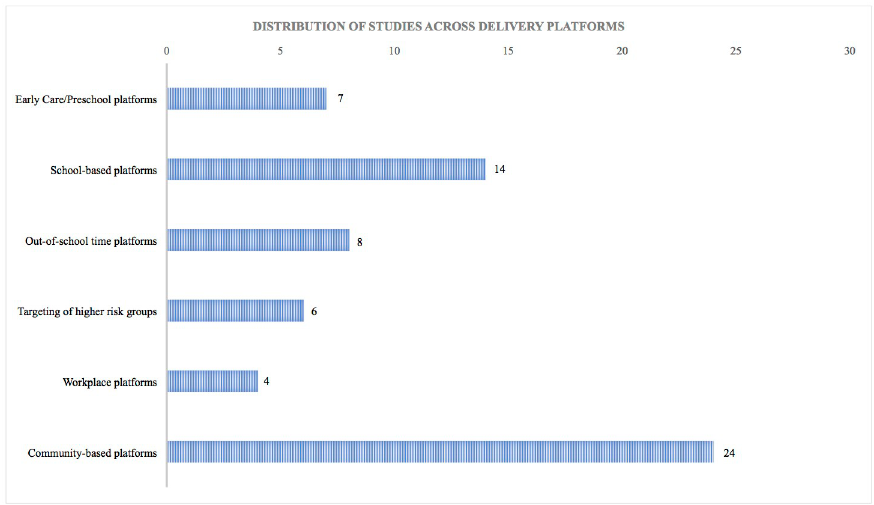
Fig 3. Distribution of studies across delivery